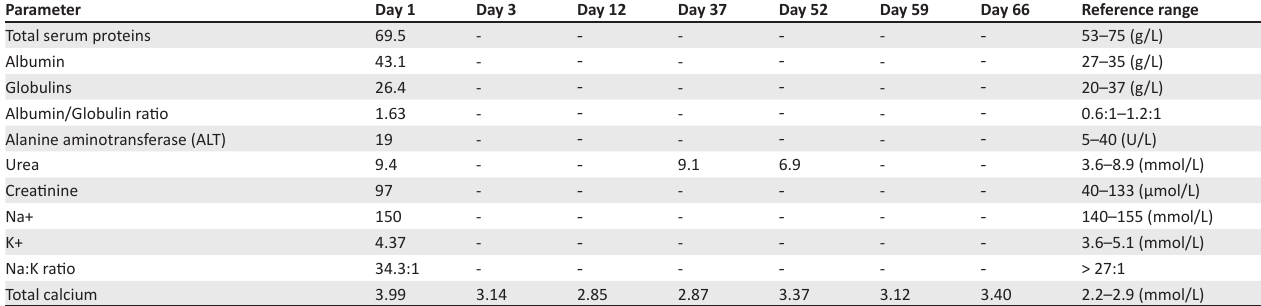
TABLE 2: Clinical chemistry values.